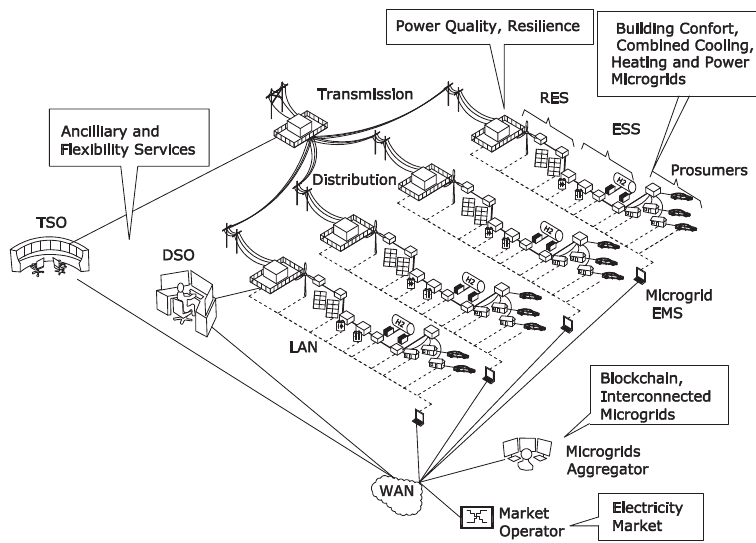
Figure 1. Overview of the main functionalities of